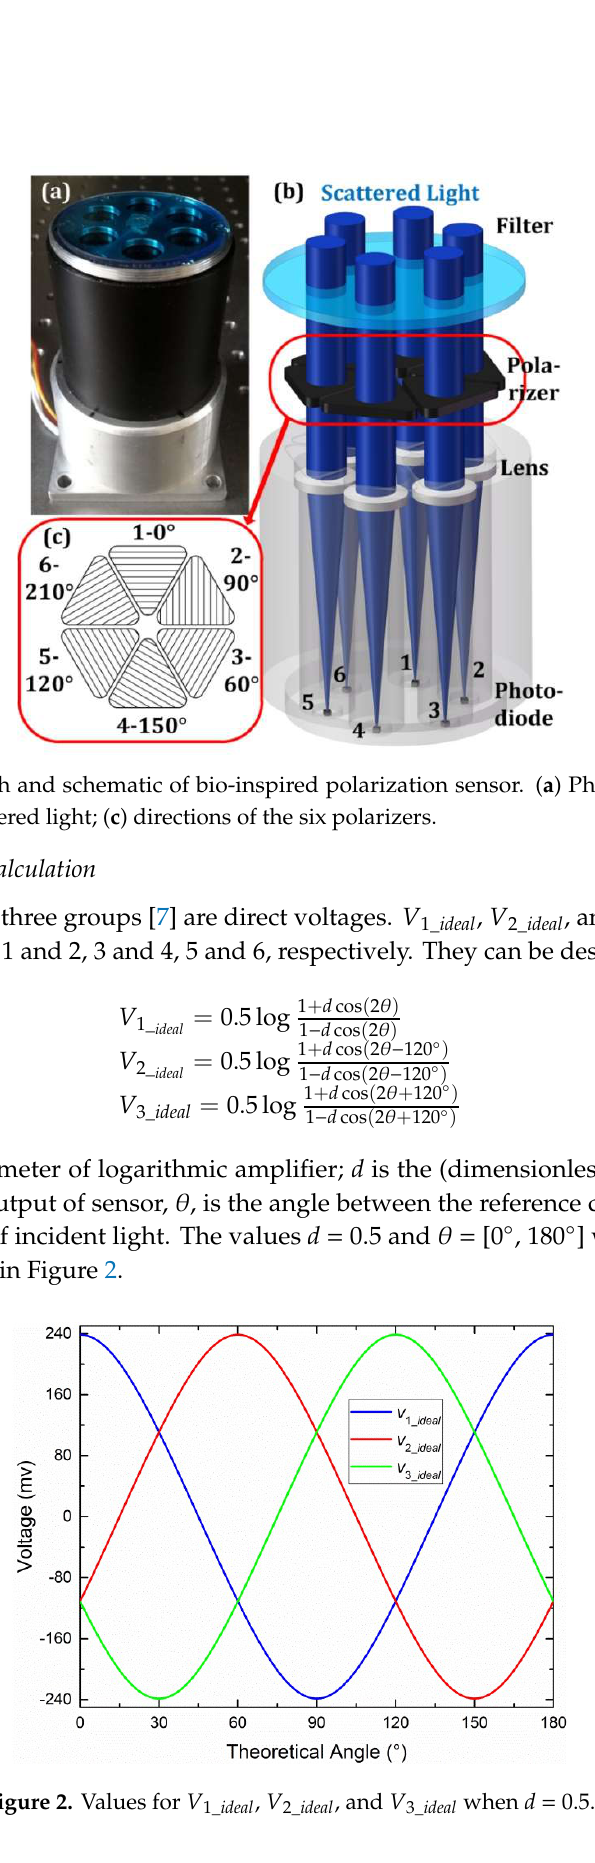
Figure 2. Values for V 1_ ideal , V 2_ ideal , and V 3_ ideal when d = 0.5.